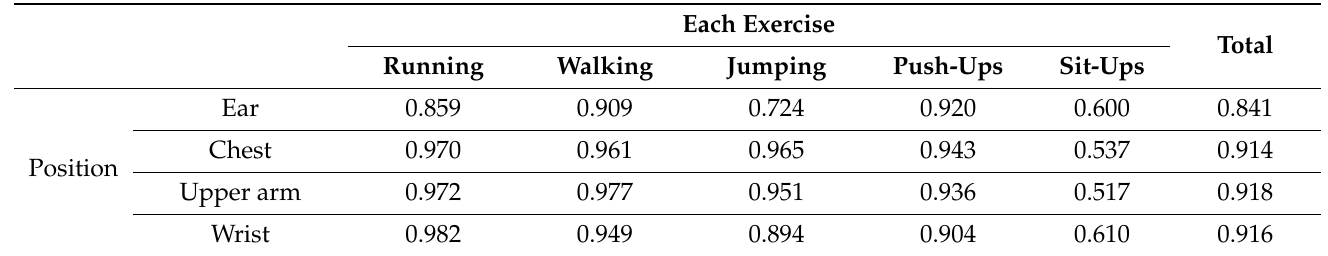
Table 2. Segmentation recalls.